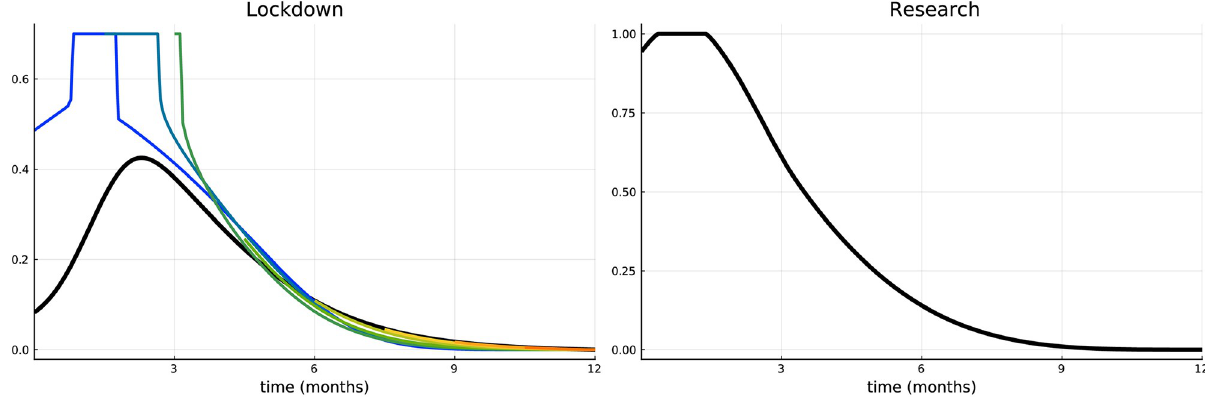
Fig 8. Convex-concave lockdown costs. Lockdown intensity over time (left) and research effort over time (right).